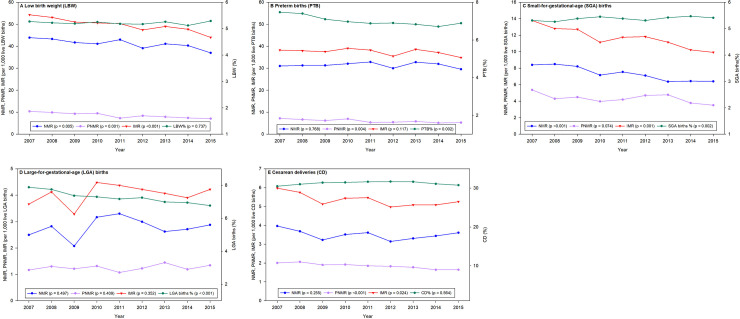
Neonatal mortality rate (NMR), postneonatal mortality rate (PNMR), and infant mortality rate (IMR) for singleton births only in California for 2007 to 2015 for A) LBW, B) PTB, C) SGA births, and D) LGA births and E) CD births. p values indicate the significance of a linear regression. Sub heddings: A. Low birth weight (LBW); B. Preterm births (PTB); C. Small-for-gestational-age (SGA) births; D. Large-for-gestational-age (LGA) births; E. Cesarean deliveries (CD).